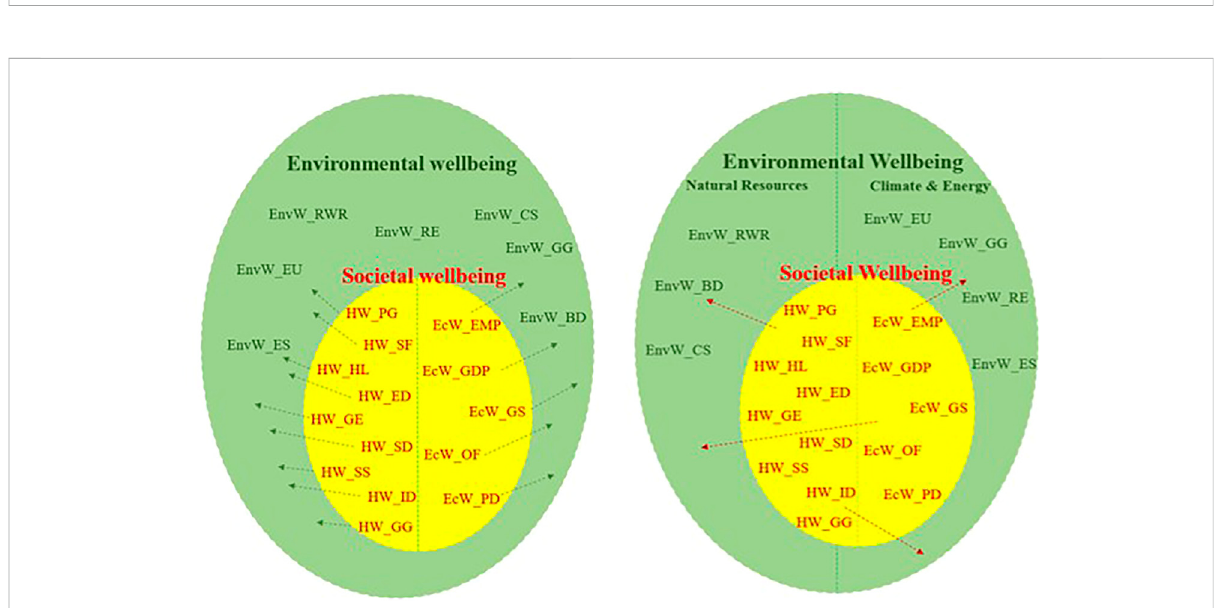
FIGURE 7 Conceptual framework of analysis starting from the perspective of Prescott-Allen (2001), using the Sustainable Society Index (SSI) framework (Van De Kerk and Manuel,